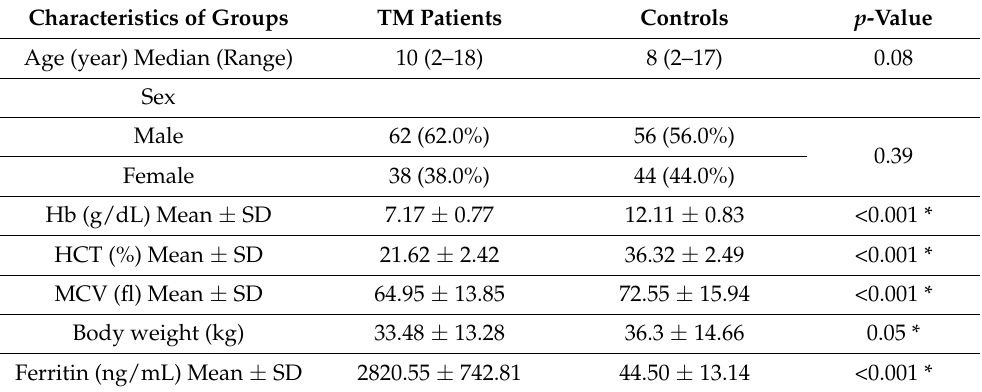
Table 1. Demographic and clinical characteristics among studied